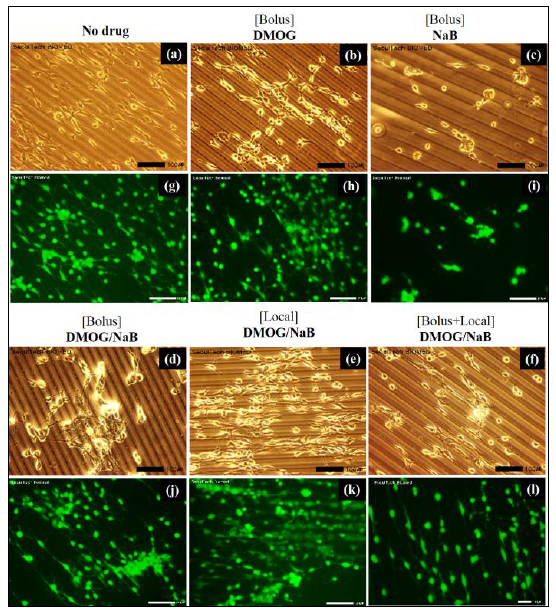
The cell clusters formation on the patterned HA gel were observed as shown in Figure 11.